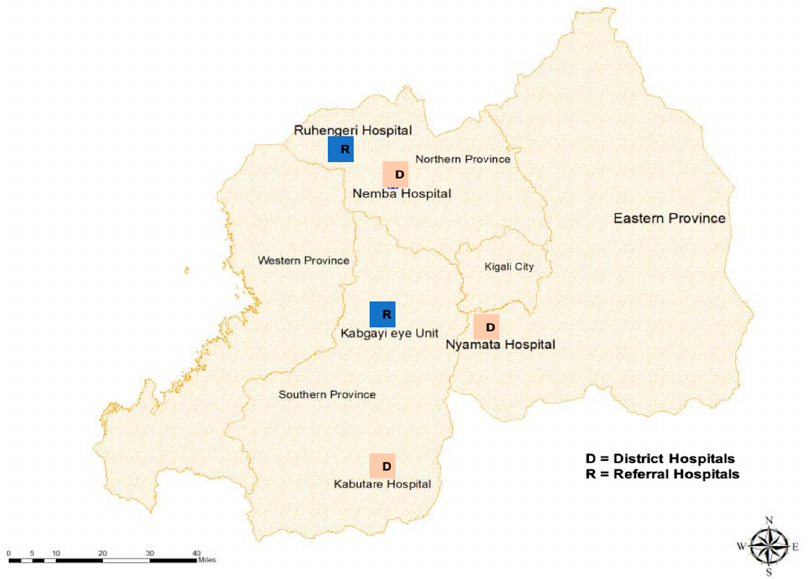
Figure 1. Locations of the two referral (R) and three district (D) hospitals in the study in